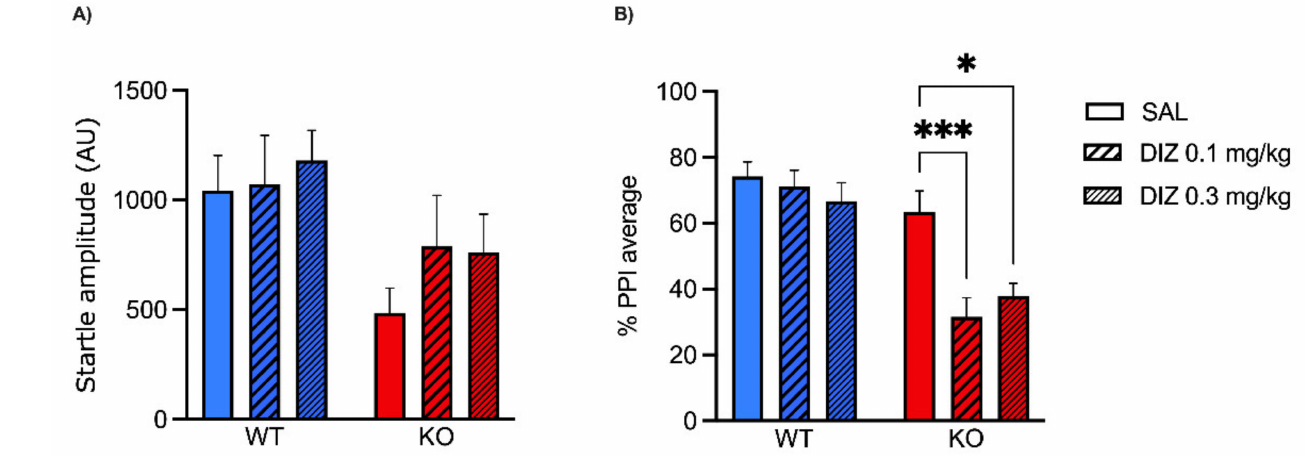
Figure 1. Effects of the uncompetitive NMDA receptor antagonist dizocilpine (DIZ; 0.1, 0.3 mg/kg, IP) on startle reflex ( A ) and prepulse inhibition ( B ) in MAOA KO mice. Data are shown as means ± SEM. Significance levels refer to the results of post hoc comparisons of two-way ANOVA analyses. Main effects are not indicated. * p < 0.05, *** p < 0.001 for comparisons indicated by bracket lines.